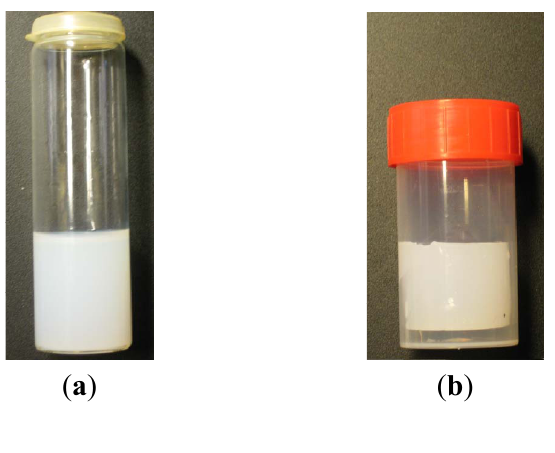
Figure 28. Visual comparison of gel shrinkage after one week for 6 wt% Na-silicate with a pH of 10.10 at 20 °C in ( a ) glass and ( b ) polypropylene